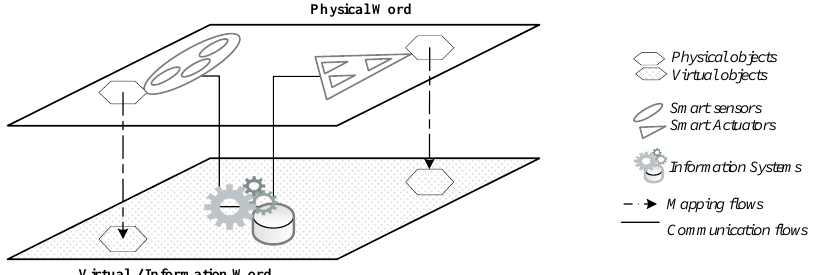
Figure 1. Technical overview of IoT enablers. Adapted from [6].